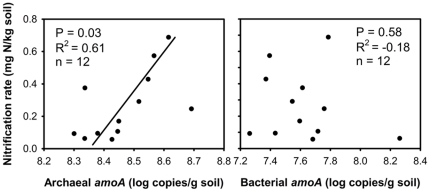
Relationship between the concentration of ammonia-oxidizing archaea/bacteria and nitrification rate.The nitrification rate was determined over the same time as our sample collection in 2009. Nitrification rate was calculated based on the accumulation of nitrate in soil bags incubated in the field (0–10 cm depth) for 15 to 32 days.